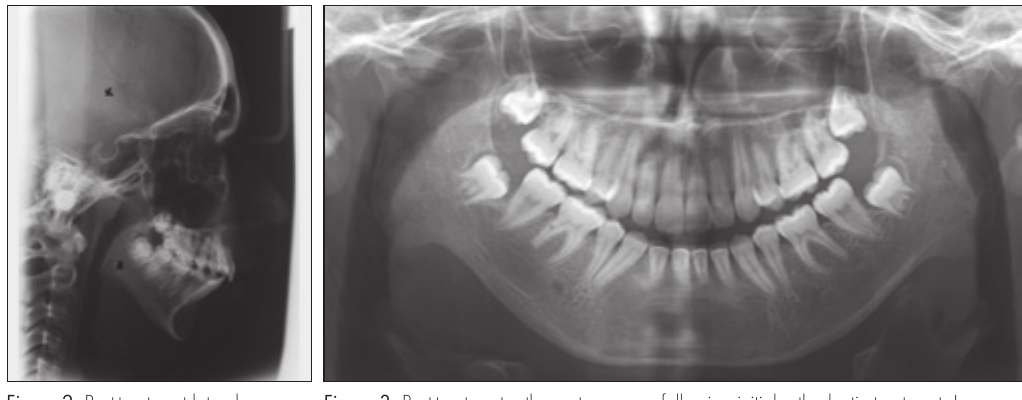
Figure 2. Post-treatment lateral cephalogram following initial orthodontic treatment; January 2010.